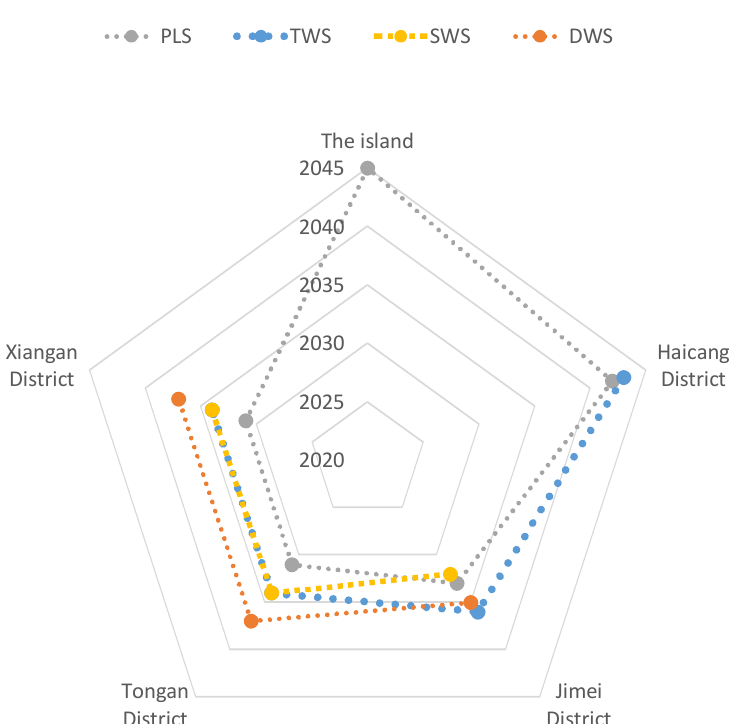
Figure 6. The time of occurrence for water shortages for each district under different scenarios. Note: